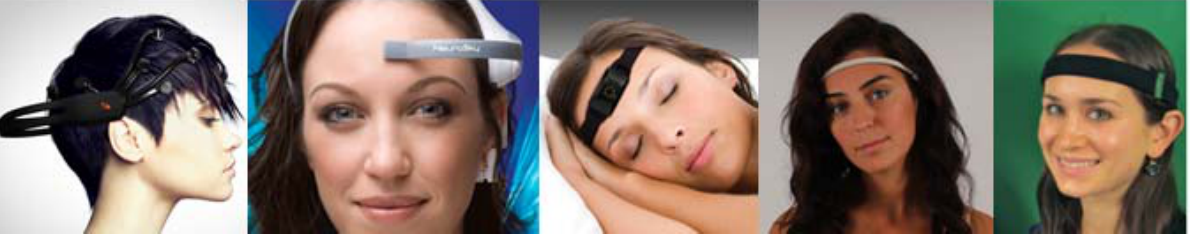
Figure 7. First- and Second-Generation Consumer EEGs: Emotiv, NeuroSky, and myZeo, and InteraXon and